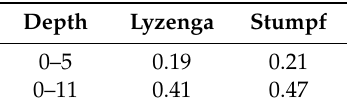
Table 3. MAD (m) of di ff erent depth ranges for UDB with Lyzenga and Stumpf models.